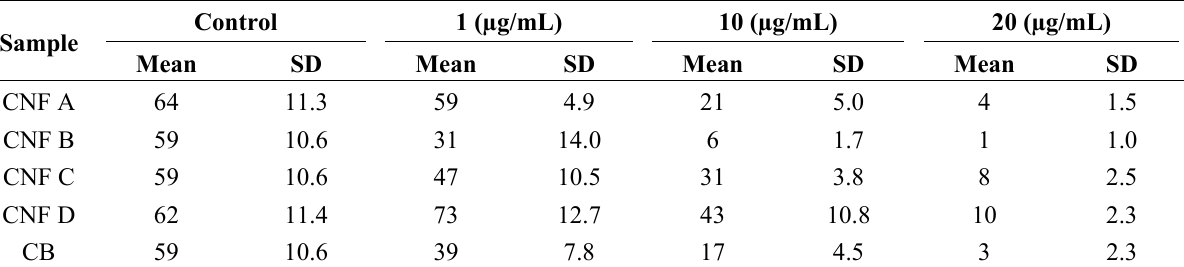
Table 3. Number of RBE4 colonies after exposure for five days to four different CNF samples. CB included as reference. Mean and standard deviation are given (n =